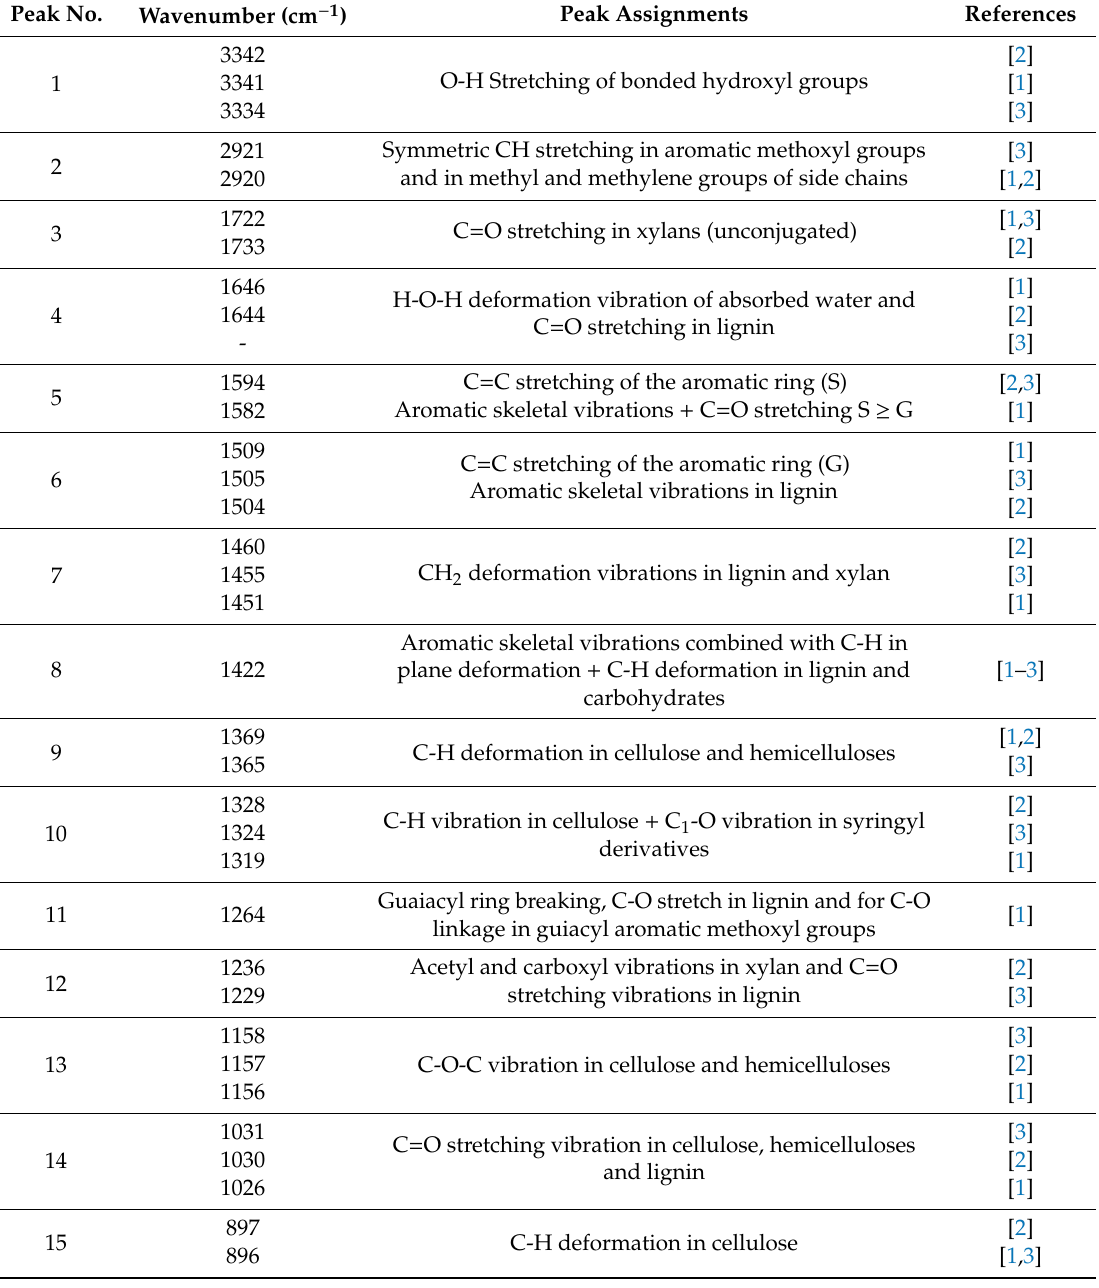
Table 1. FTIR Peak assignments in Spruce-, (1); Beech (2) and Oak control woods (3). Peak